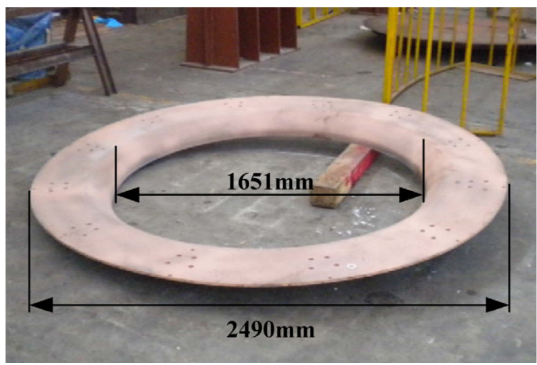
Figure 11. The practical copper screen.